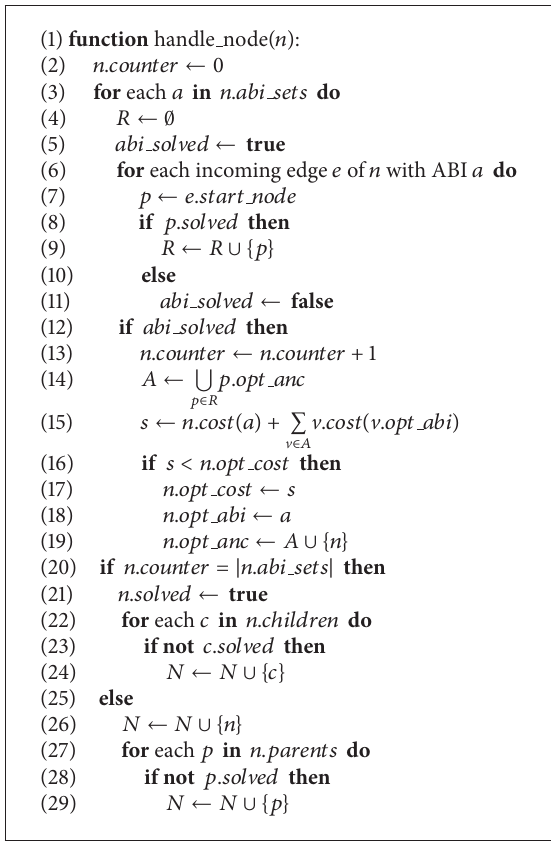
Algorithm 2: A function used by approximate OCs for